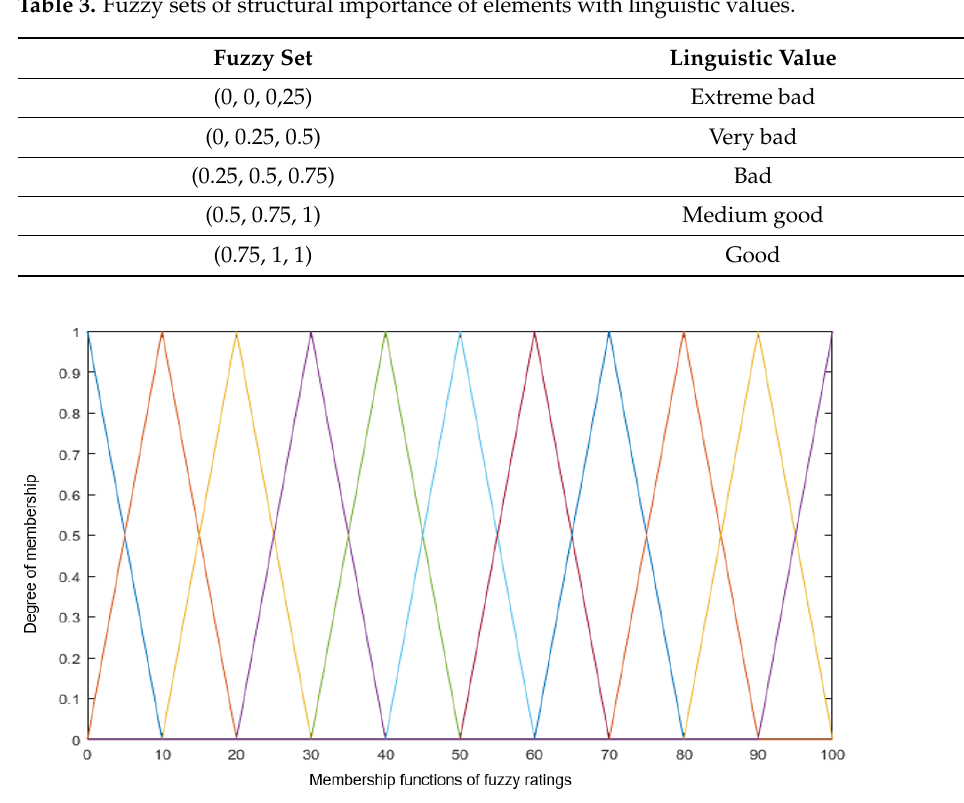
Figure 3. Membership functions of fuzzy sets of elements structural importance. In the group of photographs in Figure 4, the bridge at the river Jaruga near Mra č aj in Imotski filed is shown, where damage to the bridge can be easily observed, such as dense vegetation and seepage, cracks in the bridge elements, landslides and falling off parts of the elements. In Figure 5 the elements of the assessment bridge are marked, provided that the group of spandrel walls 2 is not visible because it is on the other (east) side of the bridge.